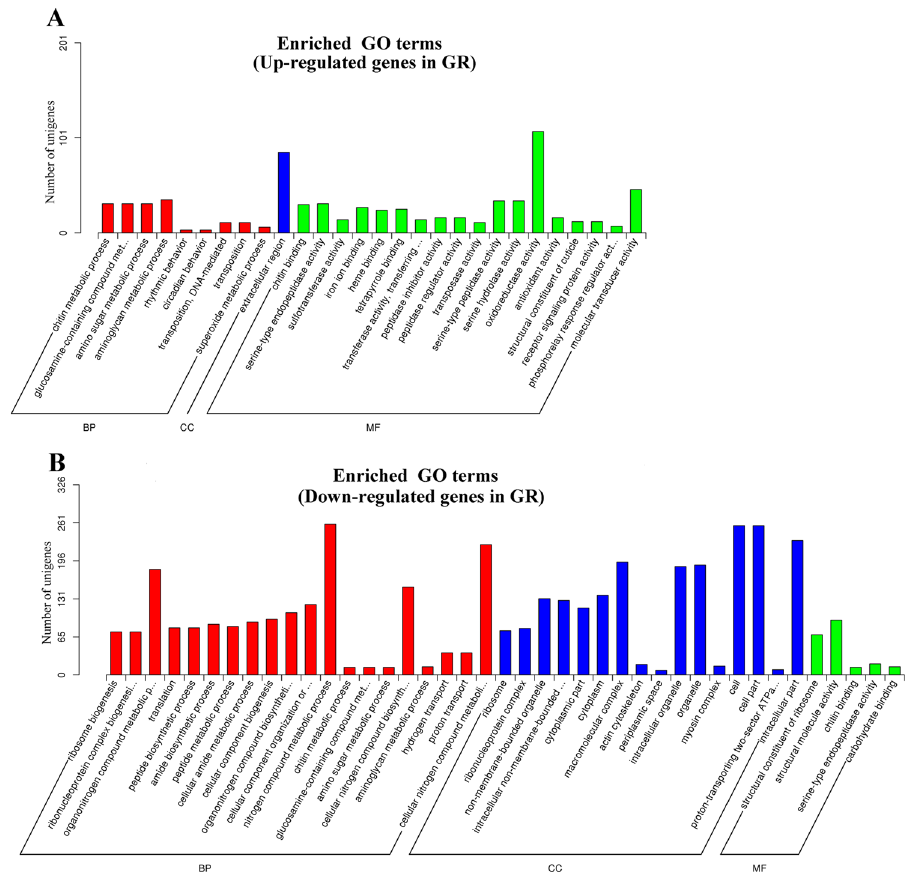
Figure 4. GO enrichment analysis of differential expressed genes (DEGs) compared to the whole transcriptome background. Upregulated DEGs ( A ) and downregulated DEGs ( B ) in GR samples with GO IDs that were categorized into three main categories shown in different colors: biological process (BP, red), cellular component (CC, blue), and molecular function (MF,